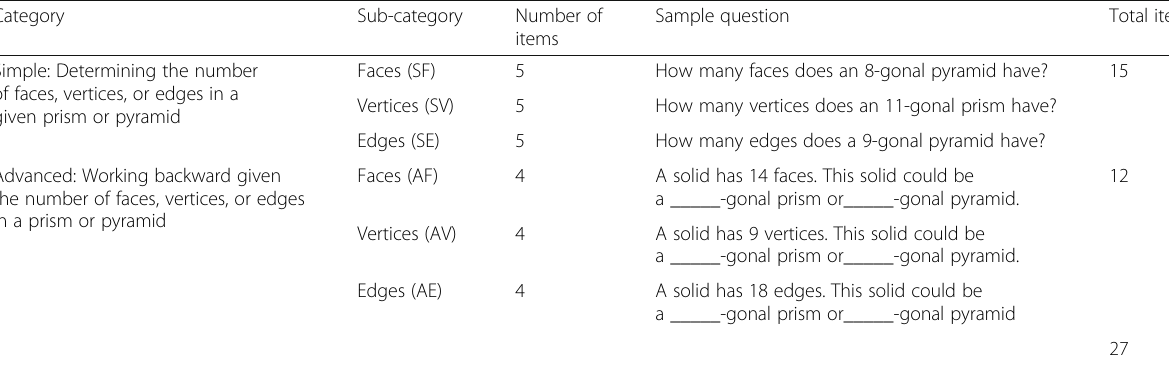
Table 1 A summary of the types of questions in student assessments